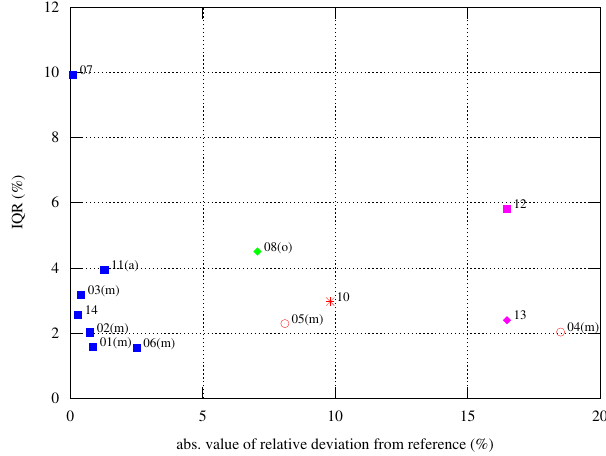
Fig. 11. Summary of the overall performances of the radiometers during clear sky days. Only results relative to the UV Index are shown. The horizontal axis represents the absolute value of the rel- ative difference between the instruments and the reference (median of the ratios of previous graphs, minus unity). The vertical axis represents the IQR distance.The shape of the markers refers to the traceability: NTP through QASUME or Bentham 5541 (squares), NIST through Kipp&Zonen facility (circles), NIST through Yankee Env. Systems facility (asterisk), NIST through ENEA Brewer #123 (diamonds). The letters beside the id numbers mark the correction methods to the measurements: spectral-angular matrix (m), only an- gular correction (a), other corrections (o) and fixed coefficient or no correction at all (no markers). Colours are used to identify instru- ments with similar characteristics (see